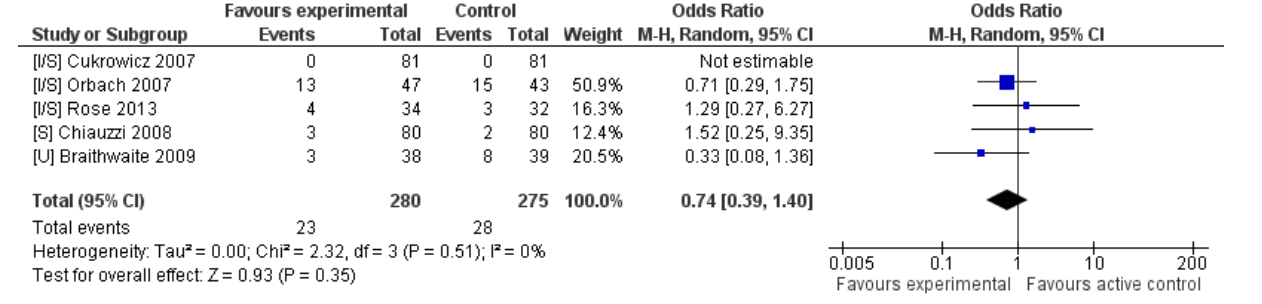
Figure 6. Attrition rates for intervention vs. active control